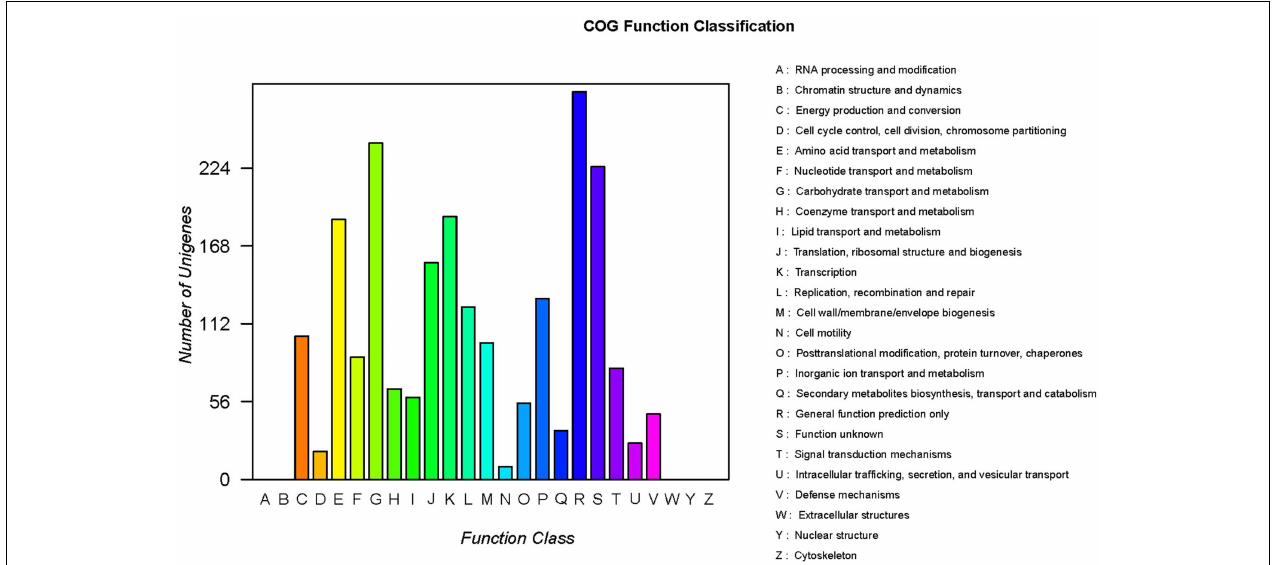
FIGURE 3 | Clusters of the orthologous group (COG) classifications of the E. faecalis sequences.